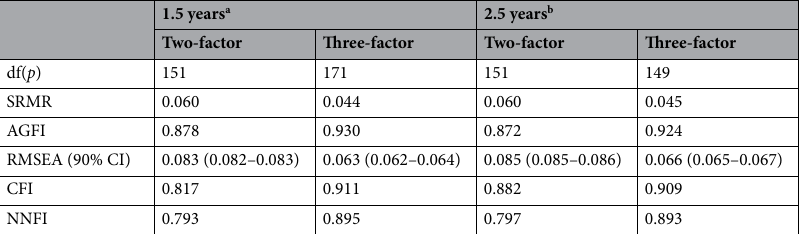
Table 3. Comparative matrix of model fit indices for the two- and three-factor structures at the two postpartum parenting periods. χ 2 chi square, df degrees of freedom, SRMR standardized root mean square residual, GFI goodness-of-fit Index, AGFI adjusted goodness-of-fit index, RMSEA (90%CI) root mean square error of approximation with 90% confidence interval, CFI Bentler comparative fit index, NNFI Bentler-Bonett non-normed fit index. a = 79,282 mothers, b = 75,831 mothers.